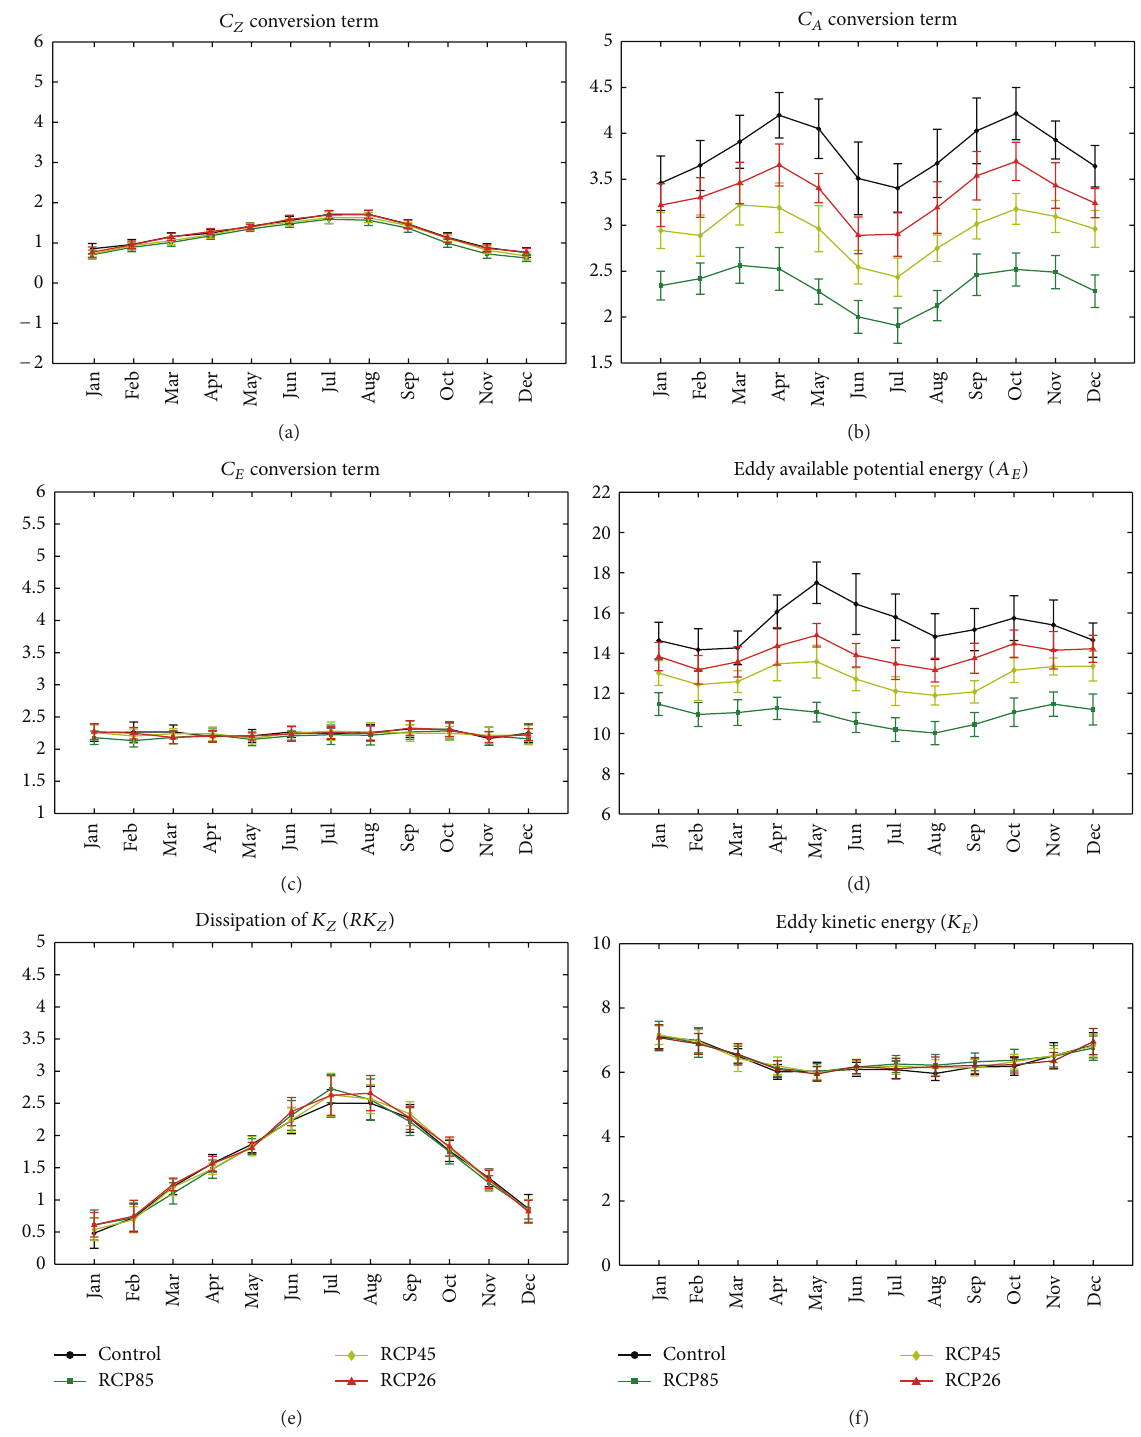
Figure 3: Climatology of the conversion terms 𝐶 𝑍 (a), 𝐶 𝐴 (b), 𝐶 𝐸 (c), and 𝐶 𝐾 (d) for the whole globe integrated between 1000 and 1hPa for RCP85, RCP45, RCP26, and control experiments. Error bars indicate 95% confidence intervals about the mean. Units are W/m 2